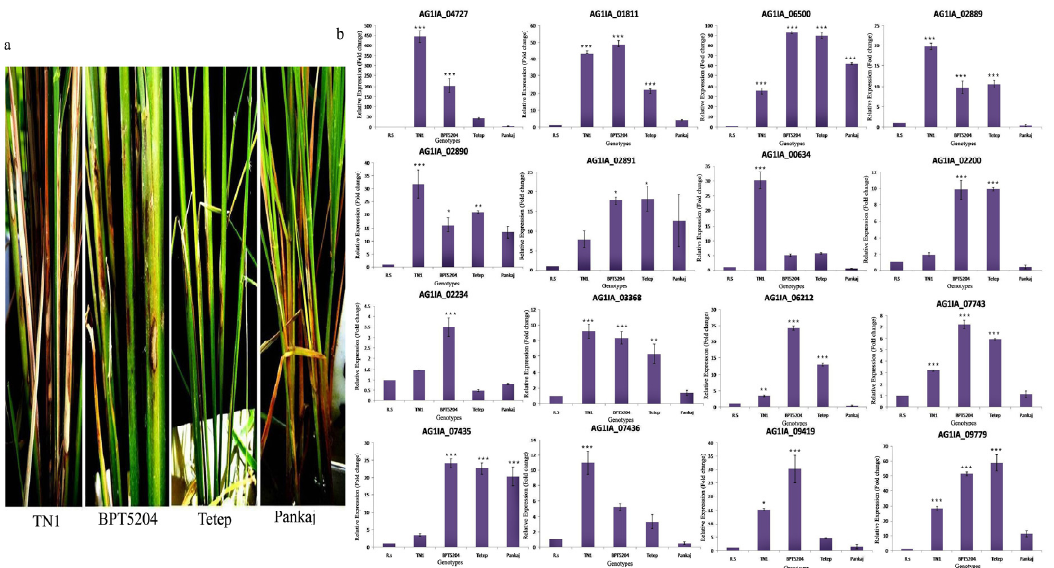
Figure 7. ( a ) The sheath blight disease symptoms on TN1, BPT5204, Tetep, and Pankaj upon inoculation of R. solani Wgl-2. ( b ) qRT-PCR expression analysis of 16 PD genes (polygalacturonases and pectinesterases) in different rice genotypes after R. solani inoculation. X-axis: samples ( R.solani inoculated sheath tissue of four genotypes); Y-axis: Expression level of the individual PD genes relative to their expression in R. solani grown in PDA. Error bars indicate the mean ± S.E. of three biological replicates. Statistical significance was determined by performing one-way ANOVA analyses followed by a Tukey’s test (*= p <0.01, **= p <0.001, and ***= p <0.0001).